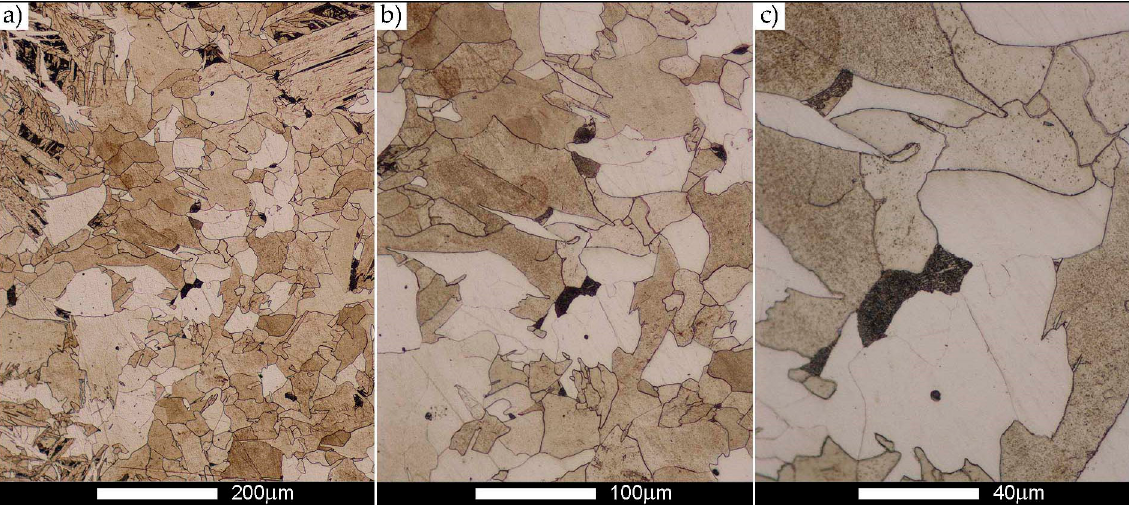
Figure 62. Welded joint microstructure of Hardox 450 steel with visible prior austenite grain boundaries, austenitised at 1200 ◦ C—HAZ zone. ( a ) 100 × ; ( b ) 200 × ; ( c ) 500 × .